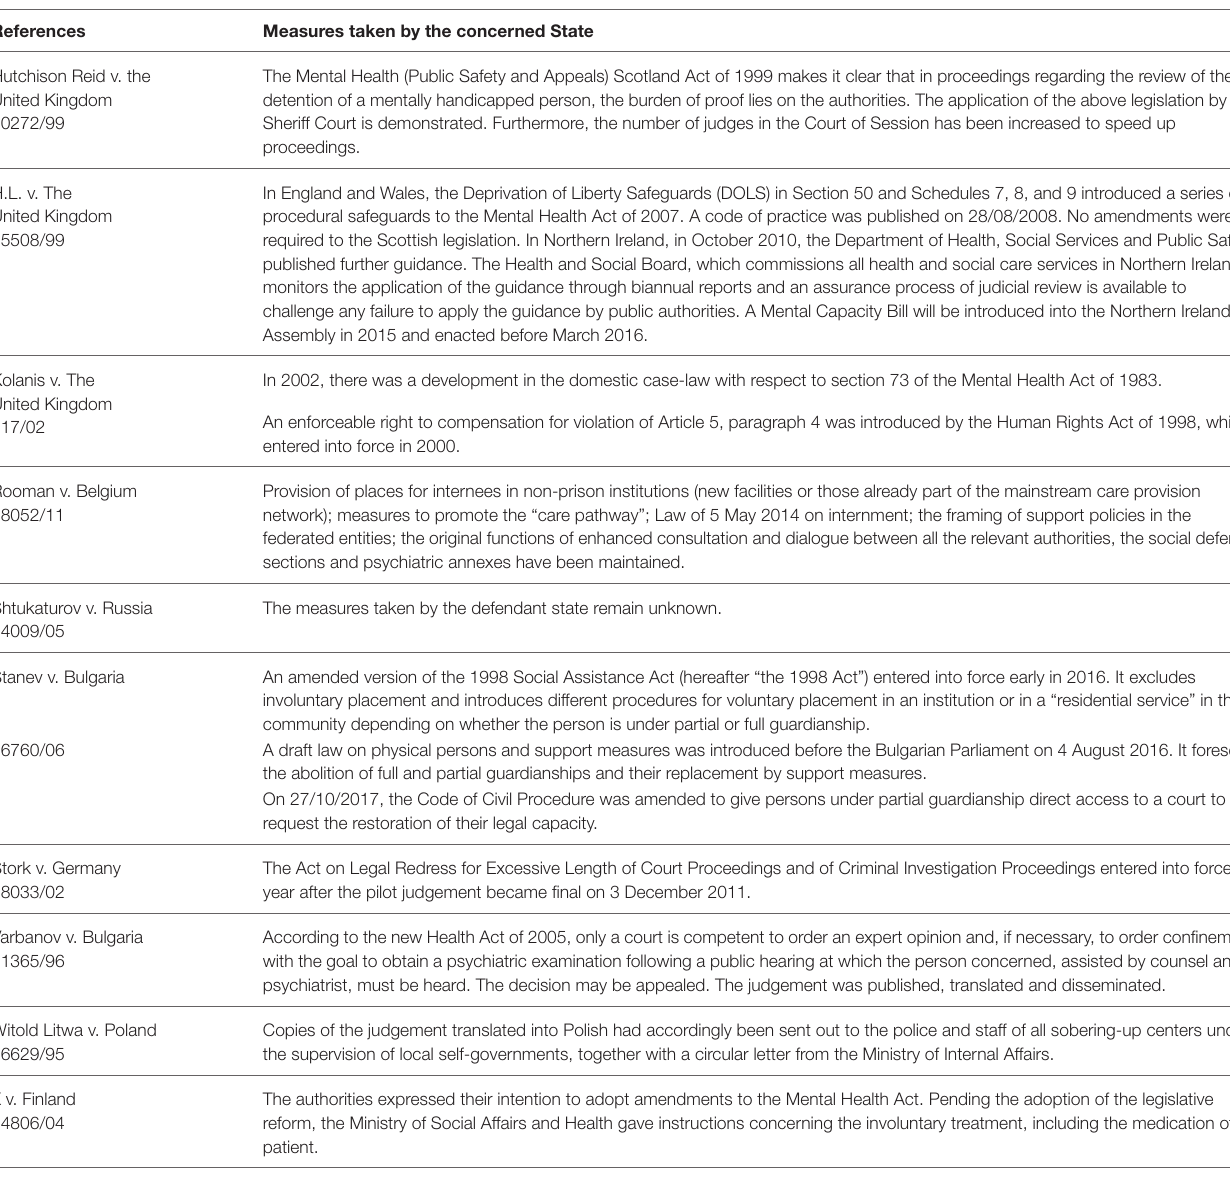
TABLE 4 | Consequences of the pilot case law of the ECtHR on national legislations (text extracted from the Council of Europe HUDOC EXEC